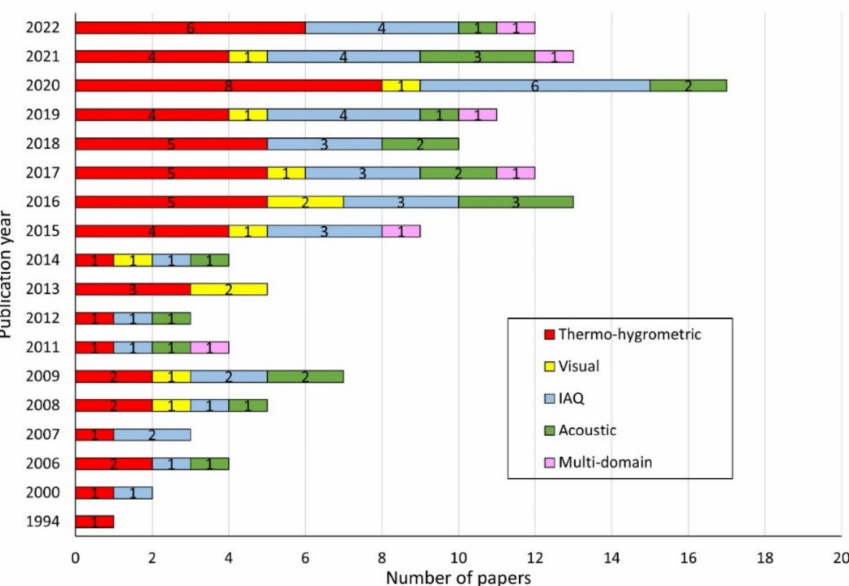
Figure 6. Association between comfort domain treated and publication year. Numbers indicate the number of papers considering each comfort domain.